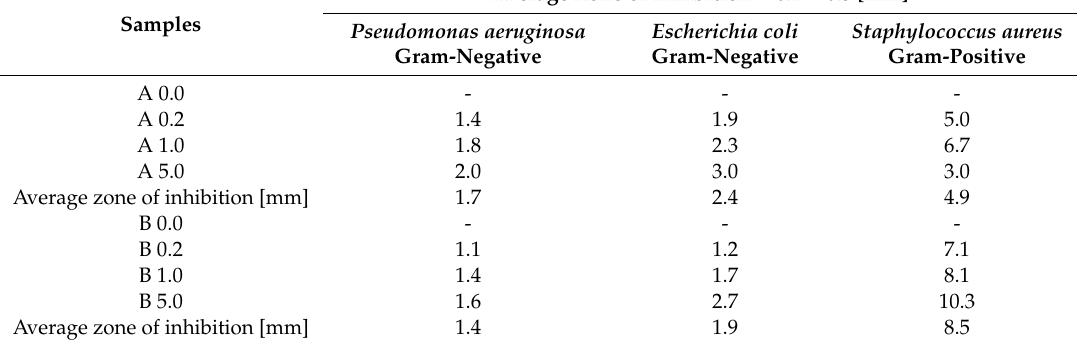
Table 6. Zone of inhibition for various sample treatments against Gram-negative Escherichia coli, Pseudomonas aeruginosa and Gram-positive Staphylococcus aureus from an average of three di ff erent experiments, with a standard deviation of ± 0.1–0.5